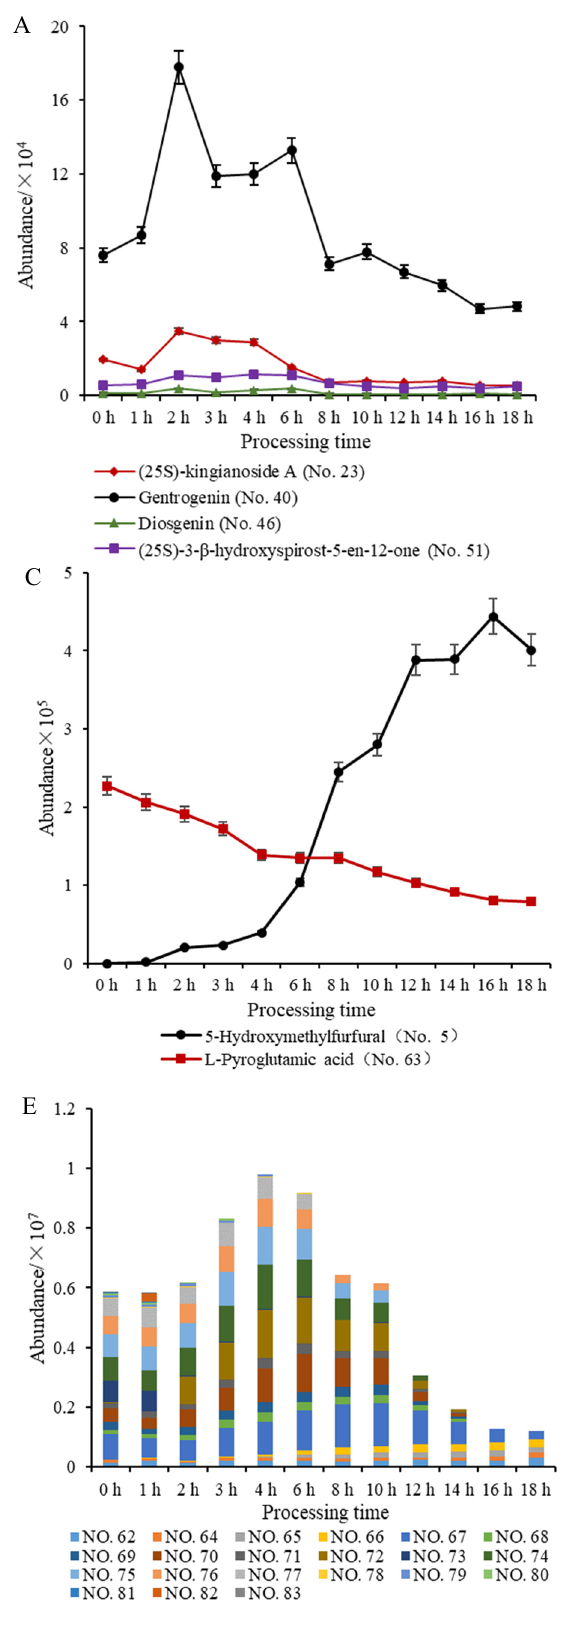
Figure 4. ( A ) Average intensity of saponin markers. ( B ) Flavonoid markers. ( C ) 5-HMF and L-pyroglutamic acid. ( D ) Linoleic acid. ( E ) Oligosaccharides and monosaccharide derivatives. ( F ) Number of oligosaccharides and monosaccharide derivatives during processing.